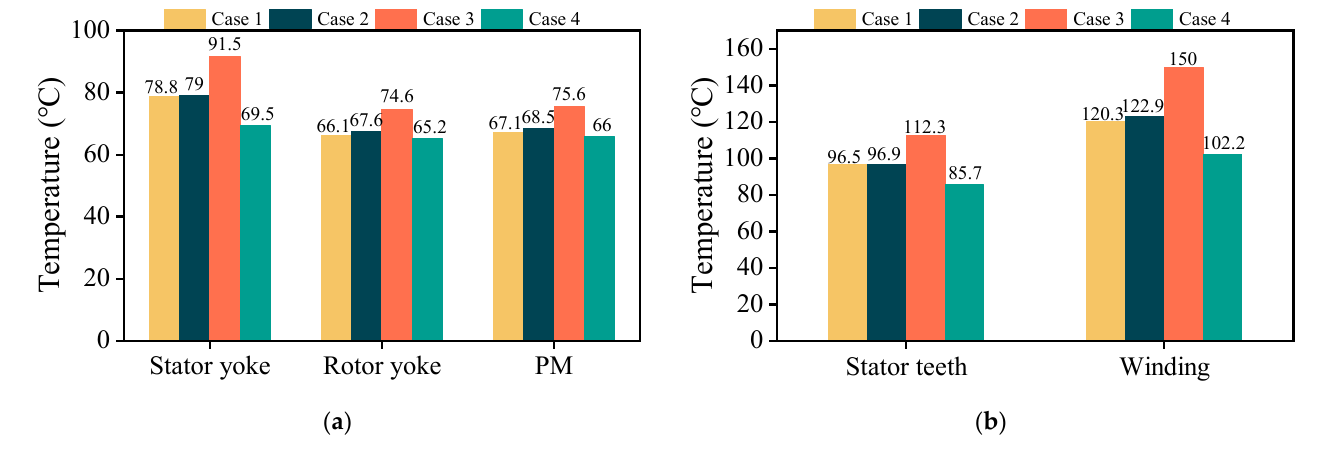
Figure 17. The temperature comparisons of four schemes: ( a ) temperature comparisons of stator yoke, rotor yoke, and PM; ( b ) temperature comparisons of stator teeth and winding.